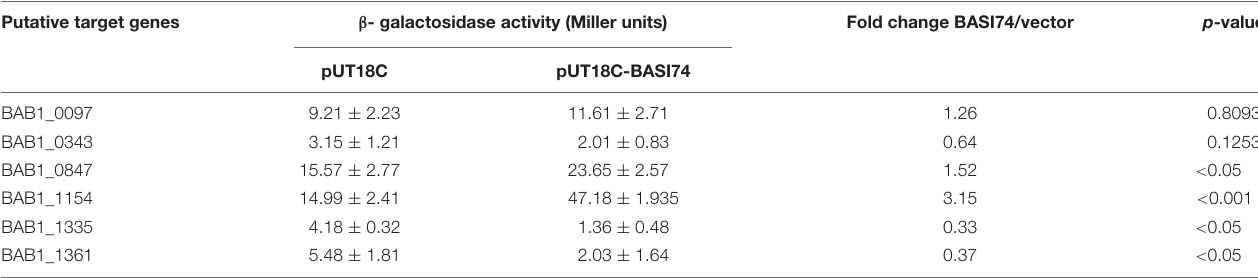
FIGURE 5 | Growth behavior of strains over-producing BASI74 under different stress conditions. (A) Over-expression of BASI74 did not affect the survival ratio of B. abortus in acidic medium (TSB pH 4.5). (B) The 2308-BASI74 strain had equal sensitivity to 30% H 2 O 2 compared to two control strains. (C) BASI74 affected bacteria growth in Brucella minimum medium. (D) Over-expression of BASI74 reduced the survival ratio of B. abortus under iron-limiting condition. Values represent the means of three independent experiments, and error bars indicate the SD. ∗ indicated the p < 0.05. ∗∗ indicated the p < 0.01. TABLE 3 | Verification of the interaction between BASI74 and putative target sequences. Putative target genes β - galactosidase activity (Miller units) Fold change BASI74/vector p -value